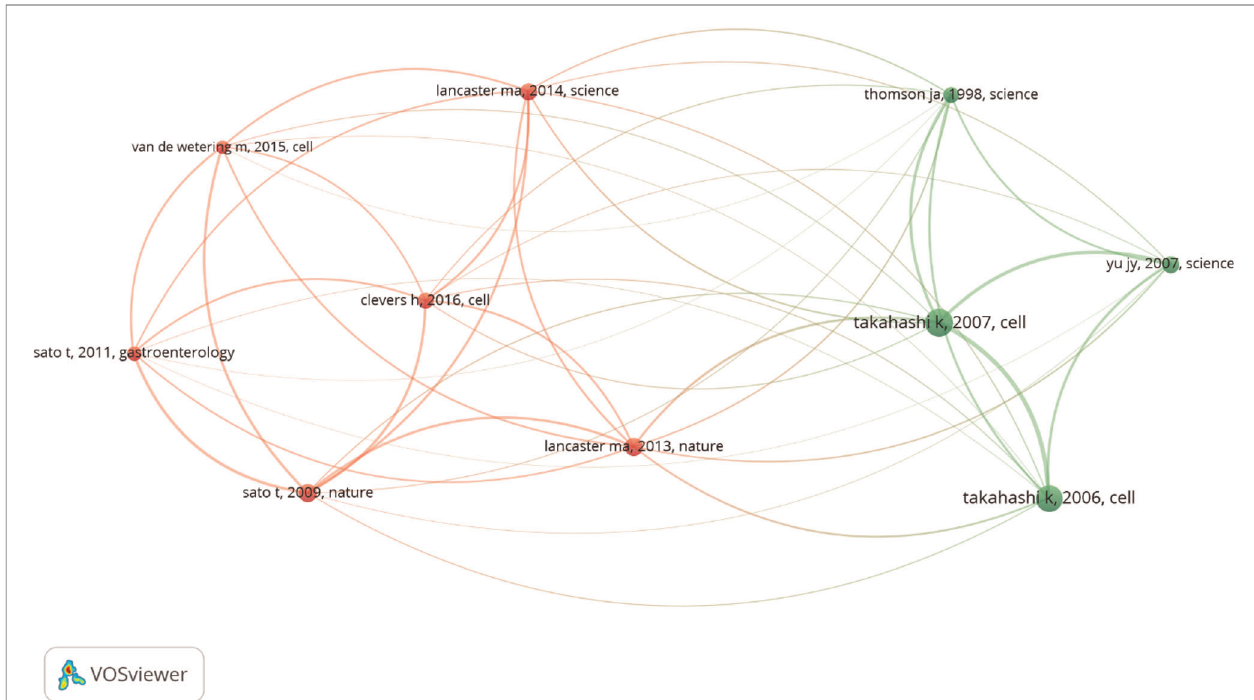
FIGURE 4 | The co-citation relationships among references (T>28) of stem cell precision medicine (2018 – 2022). The circles represent references, with the larger circle corresponding to more citations. The connecting lines represent the co-citation relationship between references, with the thicker line corresponding to more co- citations. Different colors represent different clusters automatically calculated by